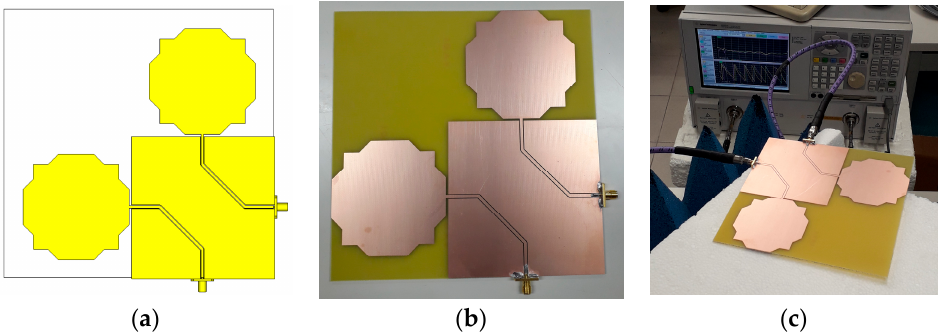
Figure 12. Dual-linearly polarized modified octagonal monopole antenna configuration. ( a ) Geometry; ( b ) Prototype; ( c ) Measurement of S-parameters with a VNA.